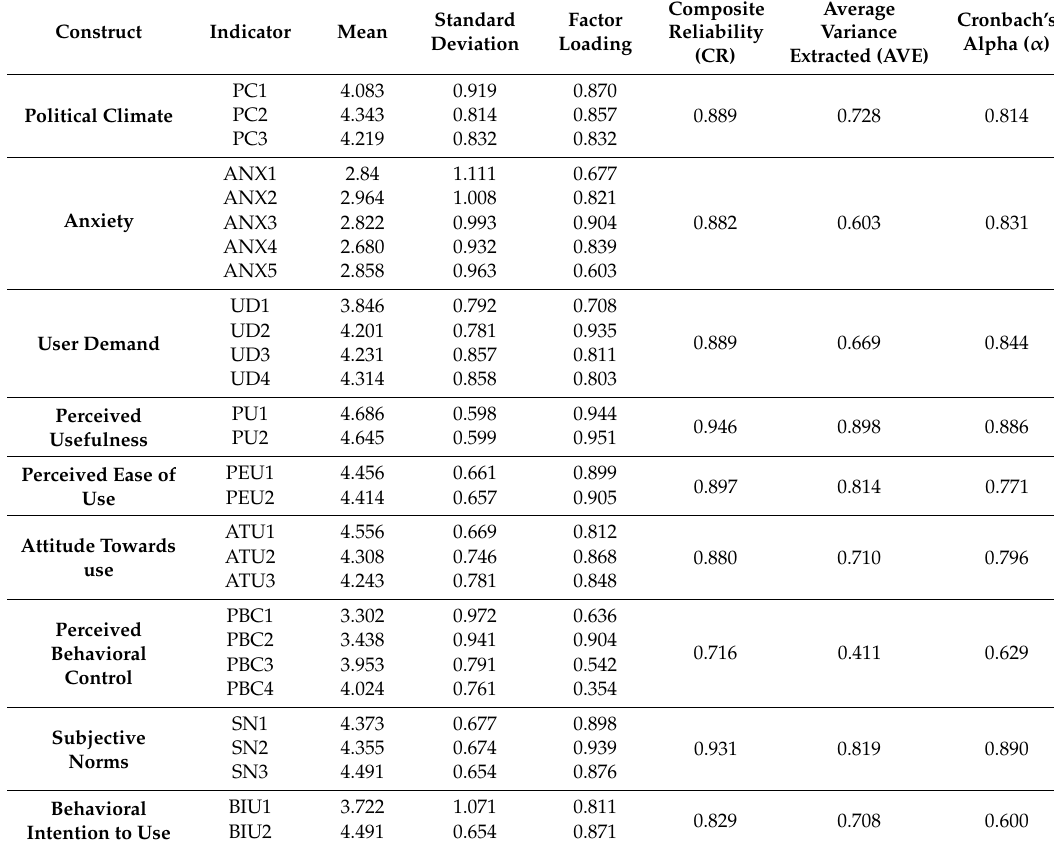
Table 6. Reliability and convergent validity analysis (for RWHS with